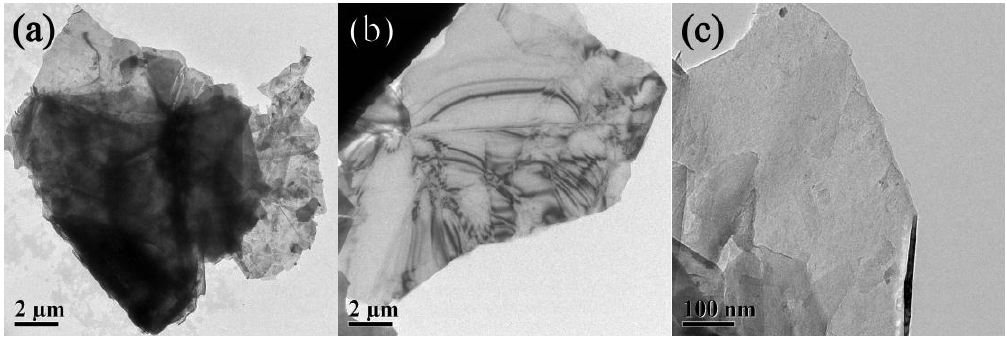
Figure 3. Transmission electron microscopy (TEM) images of GNP suspension: ( a ) before dispersion; ( b ) and ( c ) after dispersion.